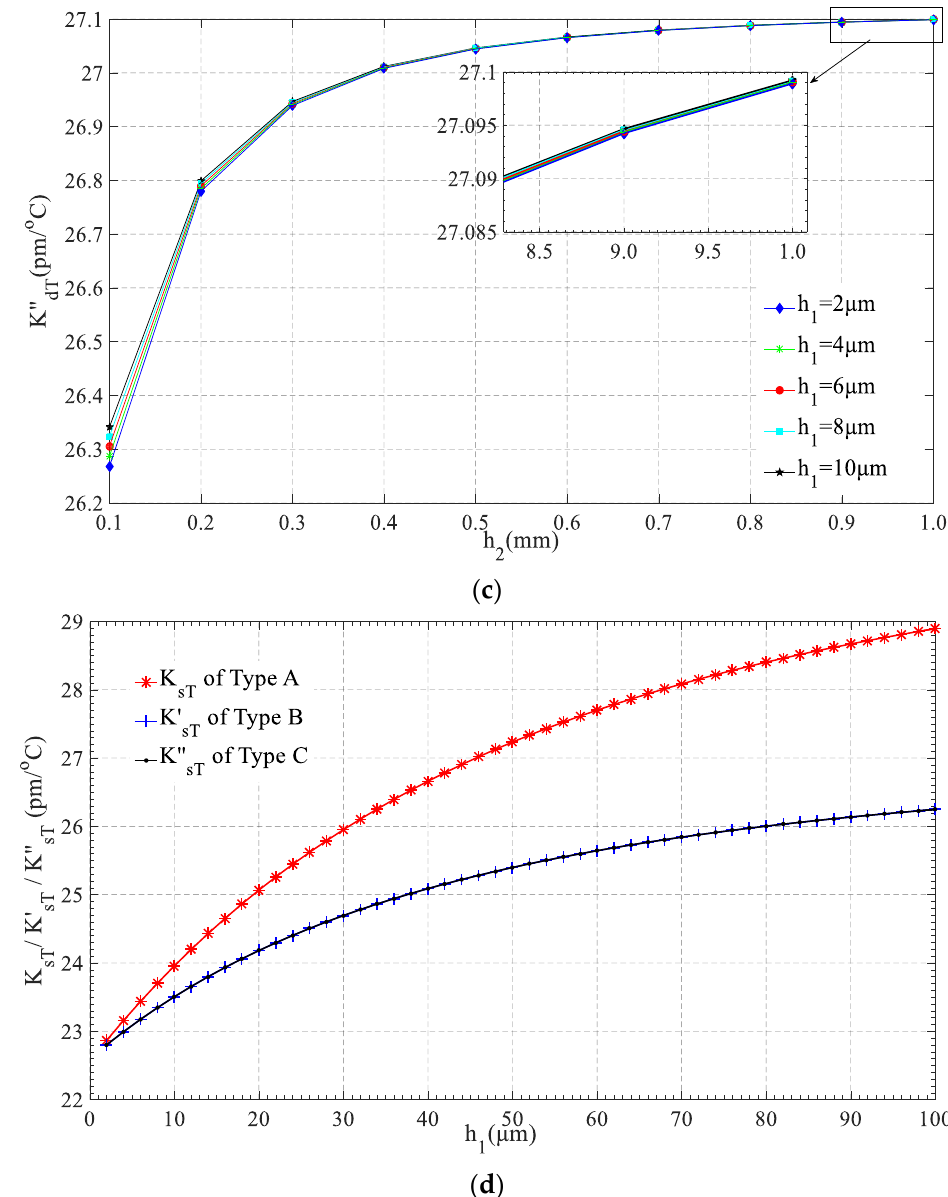
Figure 10. Temperature sensitivity of the SMC-FBGs. ( a ) double- layer’s K dT in Type A, ( b ) double- layer’s K ′ dT in Type B ( c ) double- layer’s K ′′ dT in Type C, ( d )single- layer’s K sT in Type A, K ′ sT in Type B and K ” sT in Type